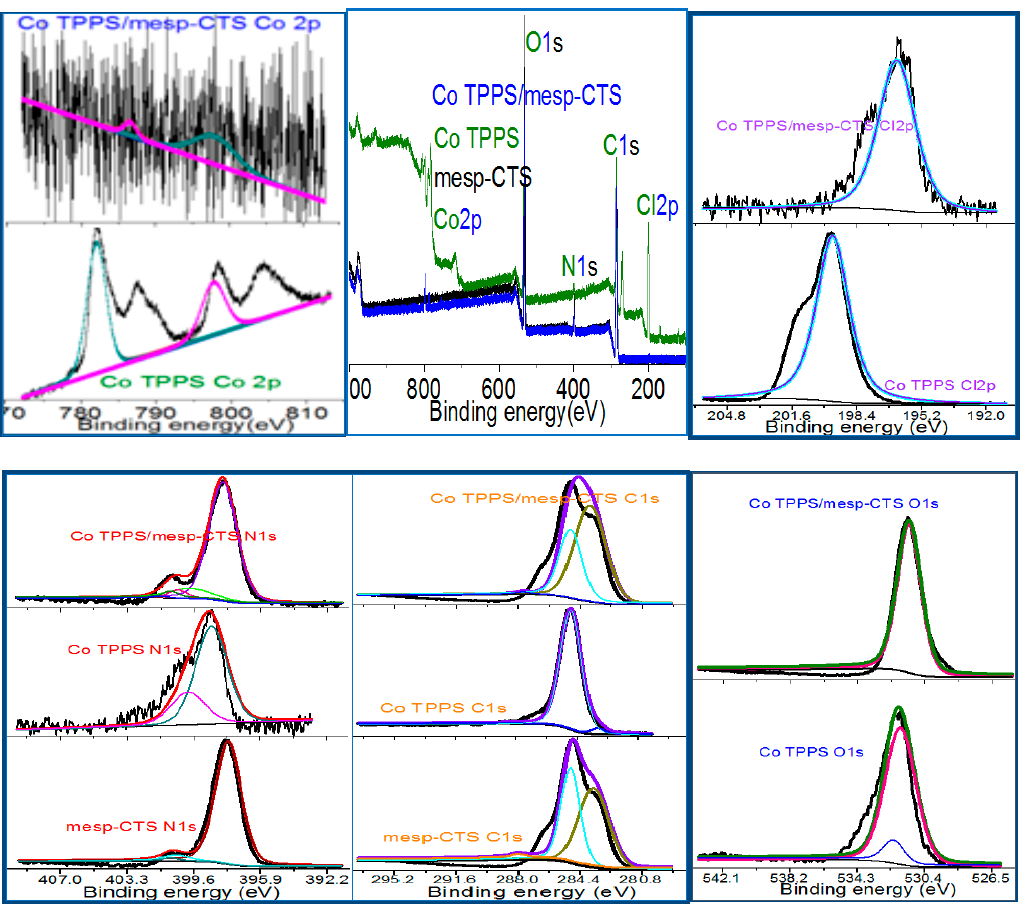
Figure 4. X-ray photoelectron spectra and main spectral bands based on the binding energy (BE) of the key elements (Co, Cl, N, and O) forCo (TPPS), Co (TPPS)/mesp-CTS, and mesp-CTS. Table 2. Binding energies of key elements. X-ray photoelectron spectroscopy (XPS).